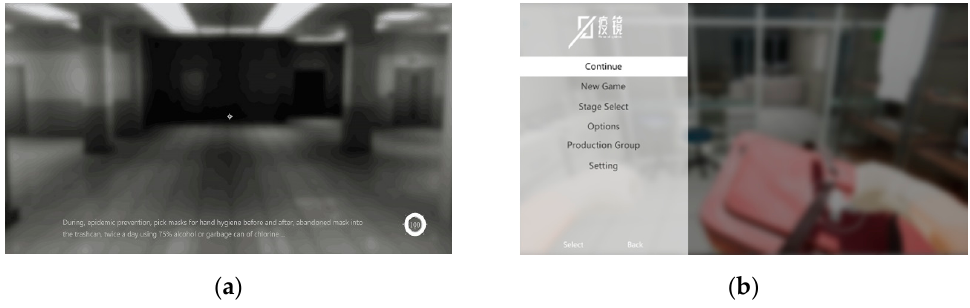
Figure 5. Menu UI: ( a ) Loading Page [9]; ( b ) Paused Menu Page.